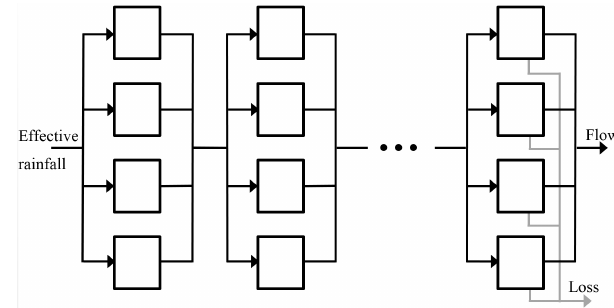
Figure 3. Unit Hydrograph model structure, including loss from last component of the cascade.